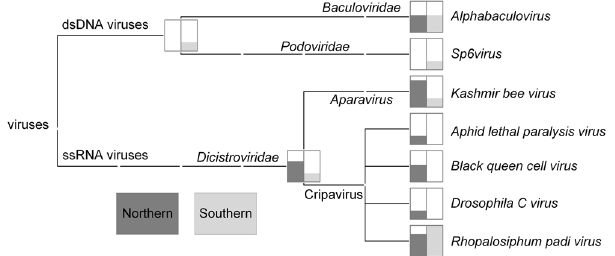
Figure 2. MEGAN taxonomic assignment of metatranscriptomic contigs. Putative viral sequences were based on BLAST similarity obtained using virus blastx matches for samples of Argentine ants from northern and southern samples. The MEGAN results were further refined using Virusfinder, Bowtie 2 and RT-PCR (Table 1).